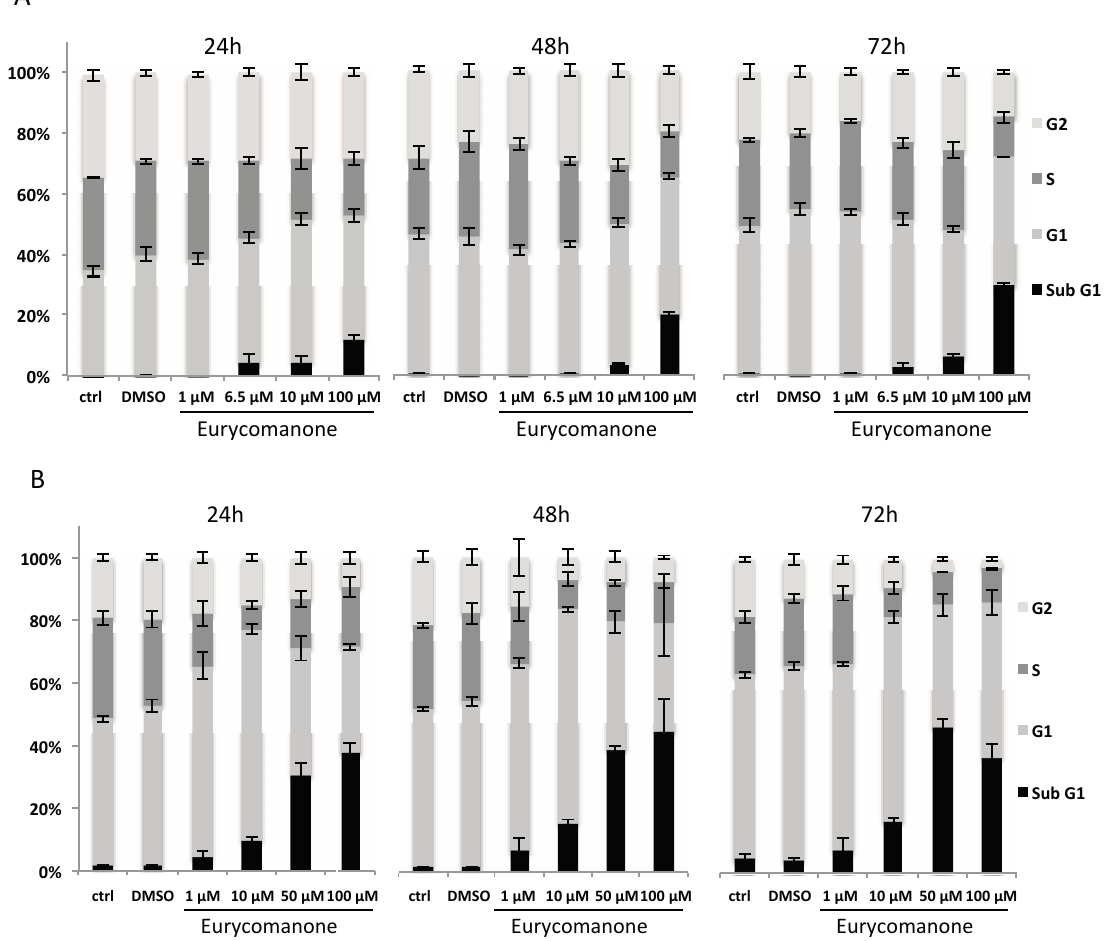
Figure 5. The effect of eurycomanone on the cell cycle distribution of K562 ( A ) and Jurkat ( B ) cells. Cell cycle analysis of K562 and Jurkat cells treated with different concentrations of eurycomanone during 24, 48 and 72 h was performed by flow cytometry. DMSO corresponds to solvent-treated control. Each value is the mean ± SD of three independent